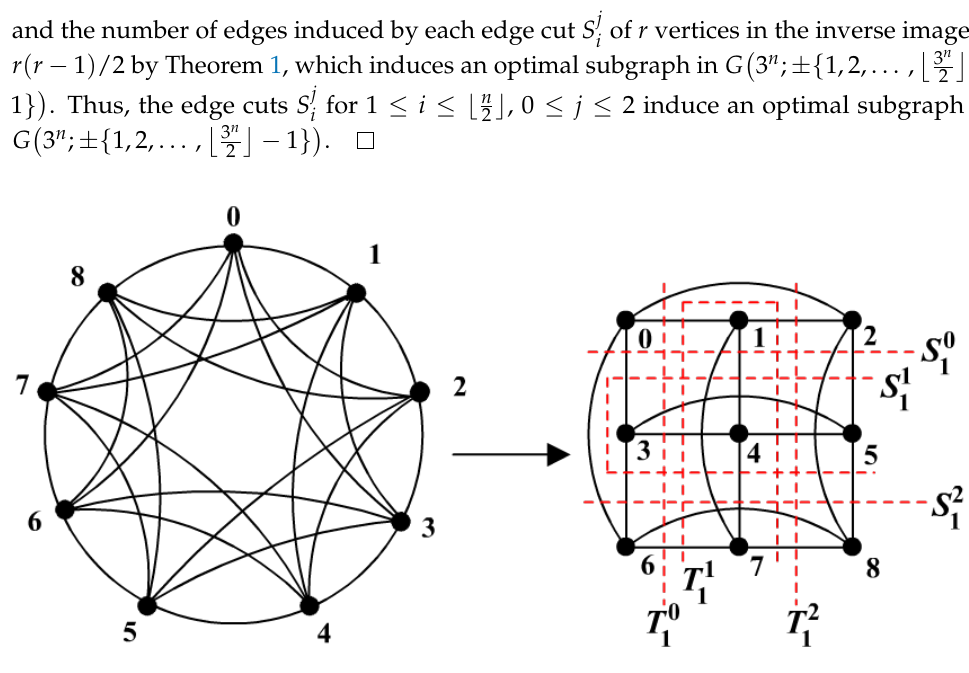
Figure 2. Embedding G ( 9; ±{ 1,2,3 } ) into H 2